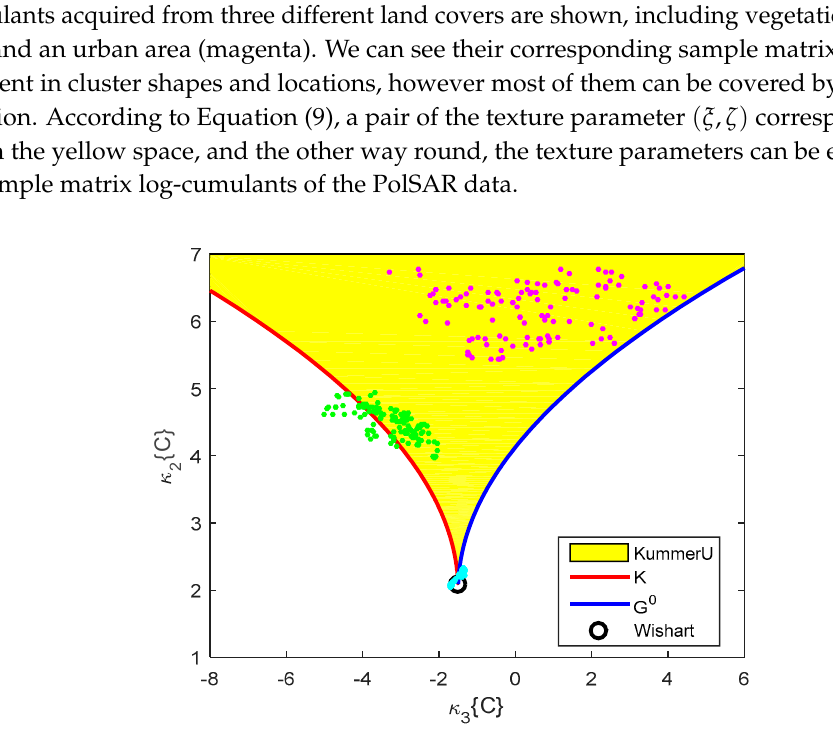
Figure 1. Theoretical matrix log-cumulants of different distributions.